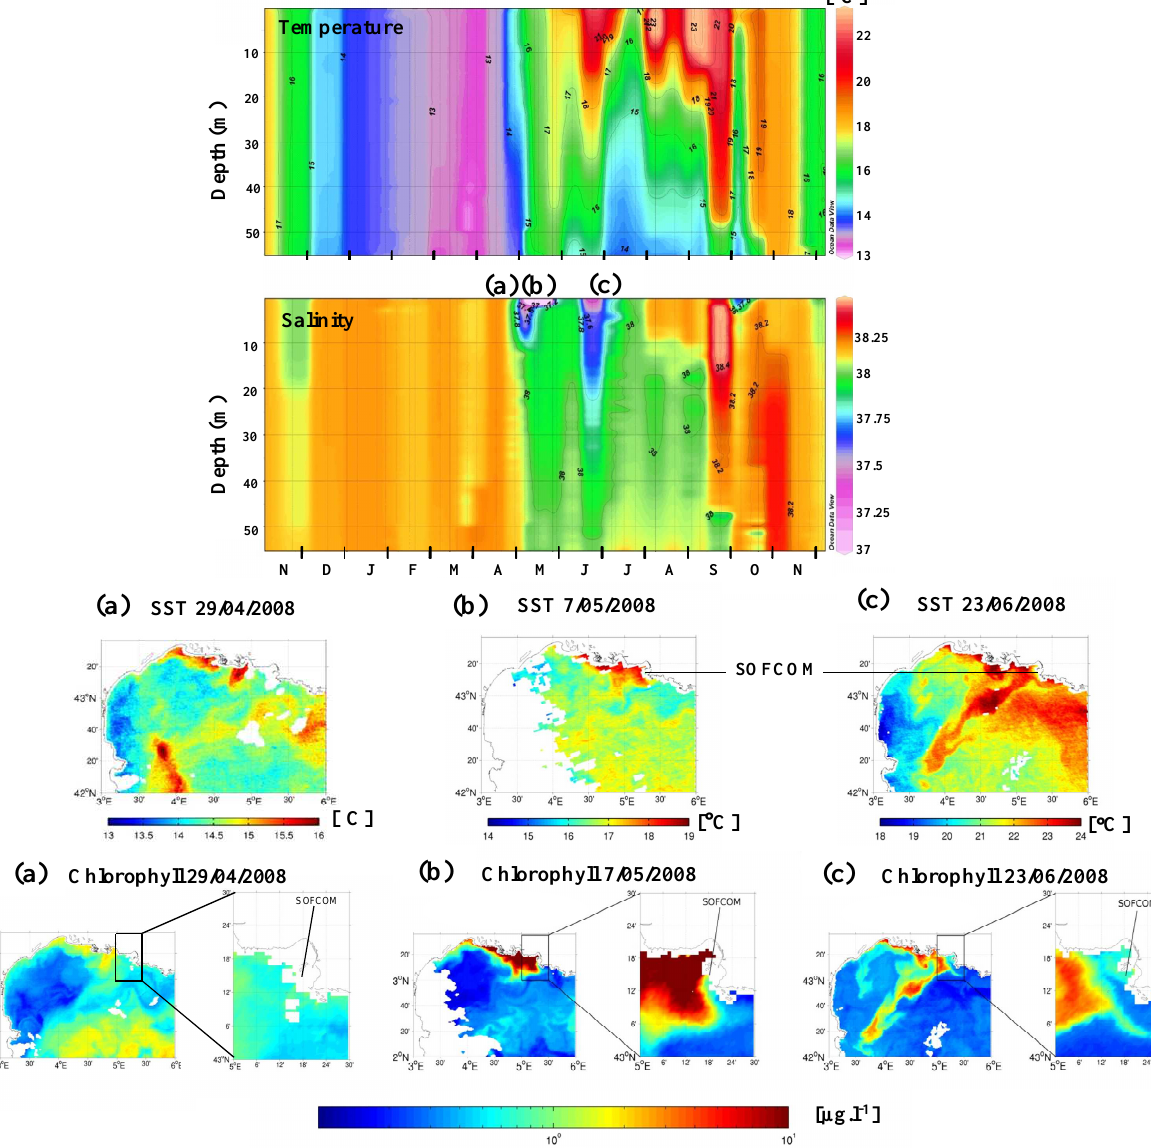
Fig. 2. Top panels: temporal evolution of temperature and salinity at SOFCOM station from November 2007 to December 2008 from surface to bottom. Data come from CTD profiles carried out twice a month by the SOMLIT network ( n = 30) and completed since February 2008 by CTD data acquired on sampling dates ( n = 11). Bottom panels: remotely sea surface temperature (SST) and chlorophyll concentrations are from the points in the time series labeled (a) , (b) and (c) corresponding respectively to the sampling date 29 April (non-intrusion of Rhˆone plume), 7 May and 23 June 2008 (intrusion of Rhˆone plume). Remotely SST and Chlorophyll concentrations from satellite images were obtained respectively by applying the long-wave SST algorithm and the OC5 coastal-oriented optical algorithm (Gohin et al., 2002, 2005) to water leaving irradiances derived from the Moderate Resolution Imaging Spectroradiometer (MODIS).